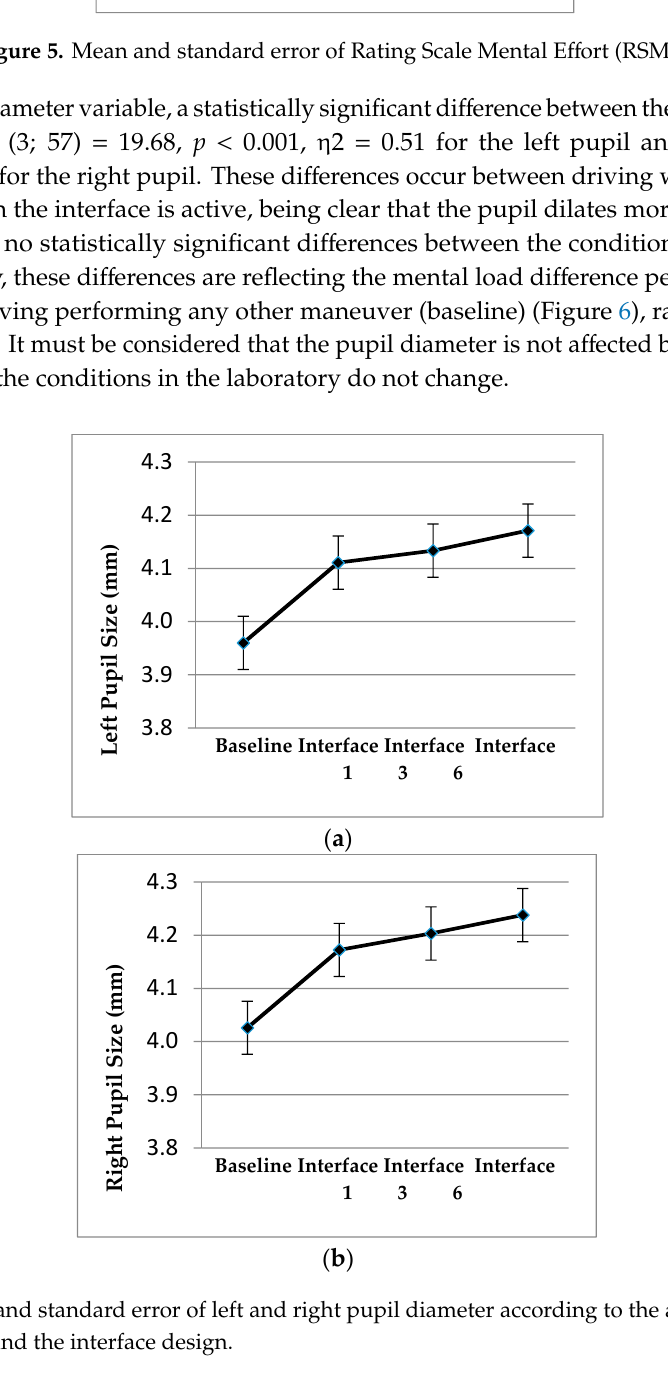
Figure 6. Mean and standard error of left and right pupil diameter according to the absence/presence of the interface and the interface design.